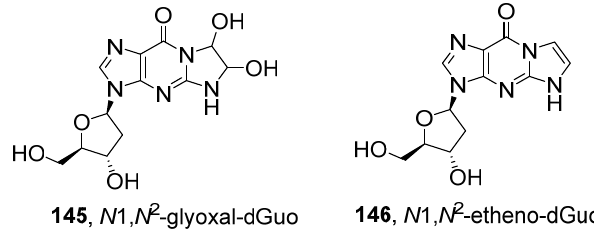
Figure 11. Structures of glyoxal and etheno DNA adducts. Catalyzed primarily by P450 2E1, hydroxylation occurs on the α -carbon of NDELA and forms the 2-hydroxyethyldiazonium ion 127 and glycolaldehyde 130 after spontaneous decomposition [188,194]. The 2-hydroxyethyldiazonium ion forms the carbocation 128 after the loss of H 2 O and subsequently yields the solvolysis product ethylene glycol 129 , which can also undergo microsome-mediated oxidation to glyoxal 133 . The carbocation 128 also undergoes elimination and forms acetaldehyde 42 [188,195]. O 6 -(2-Hydroxyethyl)-2 (cid:48) - deoxyguanosine 68 ( O 6 -HOEt-dGuo, Figure 5) arising from NDELA metabolism has been detected in rat liver DNA; it is not derived from NHMOR metabolism [191]. Deuter- ation on the α -carbon of NDELA greatly decreased the formation of glycolaldehyde 130 and O 6 -HOEt-dGuo 68 , whereas β -deuteration oppositely affected the formation of those products. This further suggests that O 6 -HOEt-dGuo mainly results from NDELA α - hydroxylation [191,194]. One unexpected finding was that glycolaldehyde 130 , other than being classically converted to glycolic acid 131 and oxalic acid 132 , was also transformed to glyoxal 133 via the catalysis of P450 2E1 [188,194]. The collective evidence indicates the necessity of the α -hydroxylation of NDELA for DNA adduct